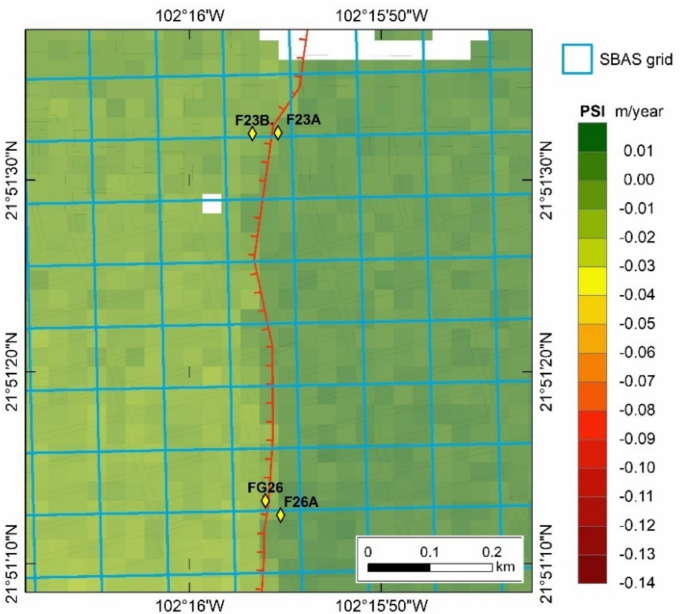
Figure 17. Location of pairs of monitoring benchmarks F23A − F23B and FG26 − FG26A with respect to the Oriente fault trace and grid coverages of SBAS (~90 m blue squares) and PSI up velocities (1 arcsecond pixels, i.e., ~30